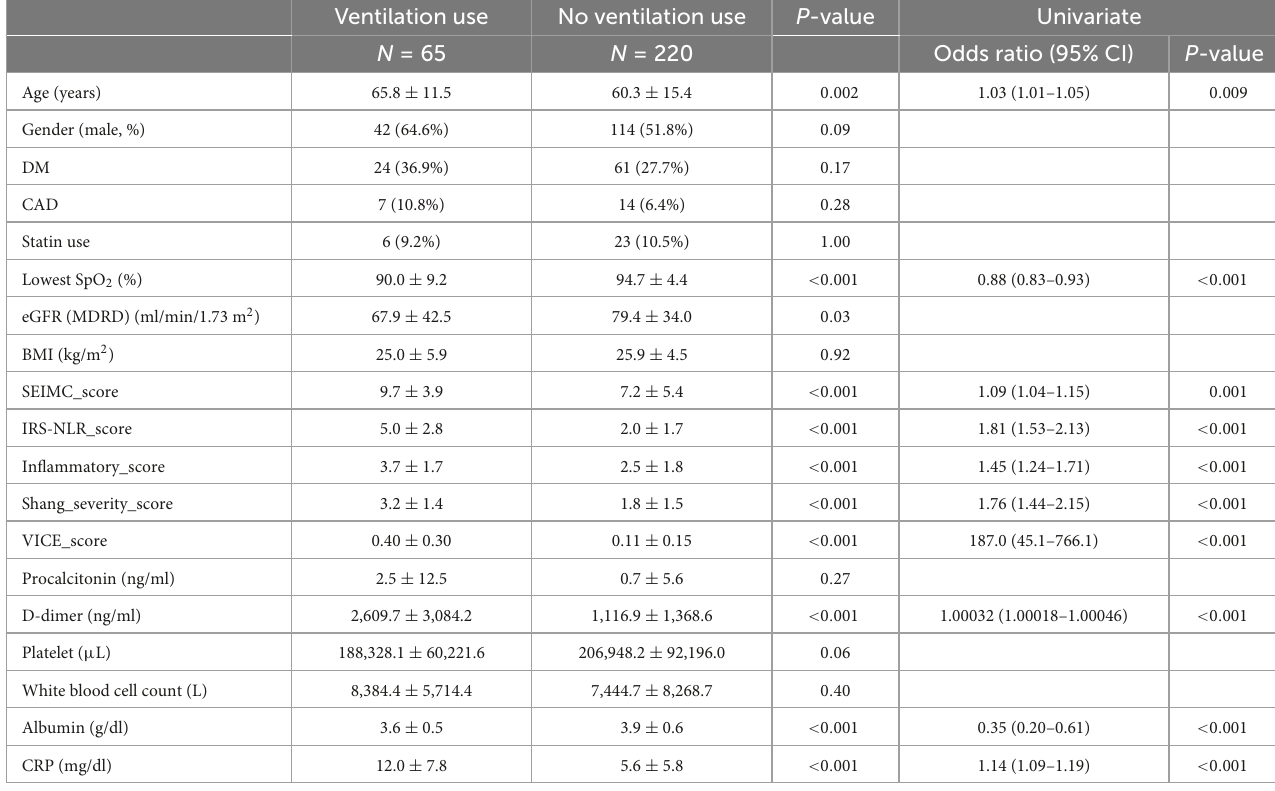
TABLE 2 Baseline characteristics and laboratory findings with and without ventilator use with COVID-19